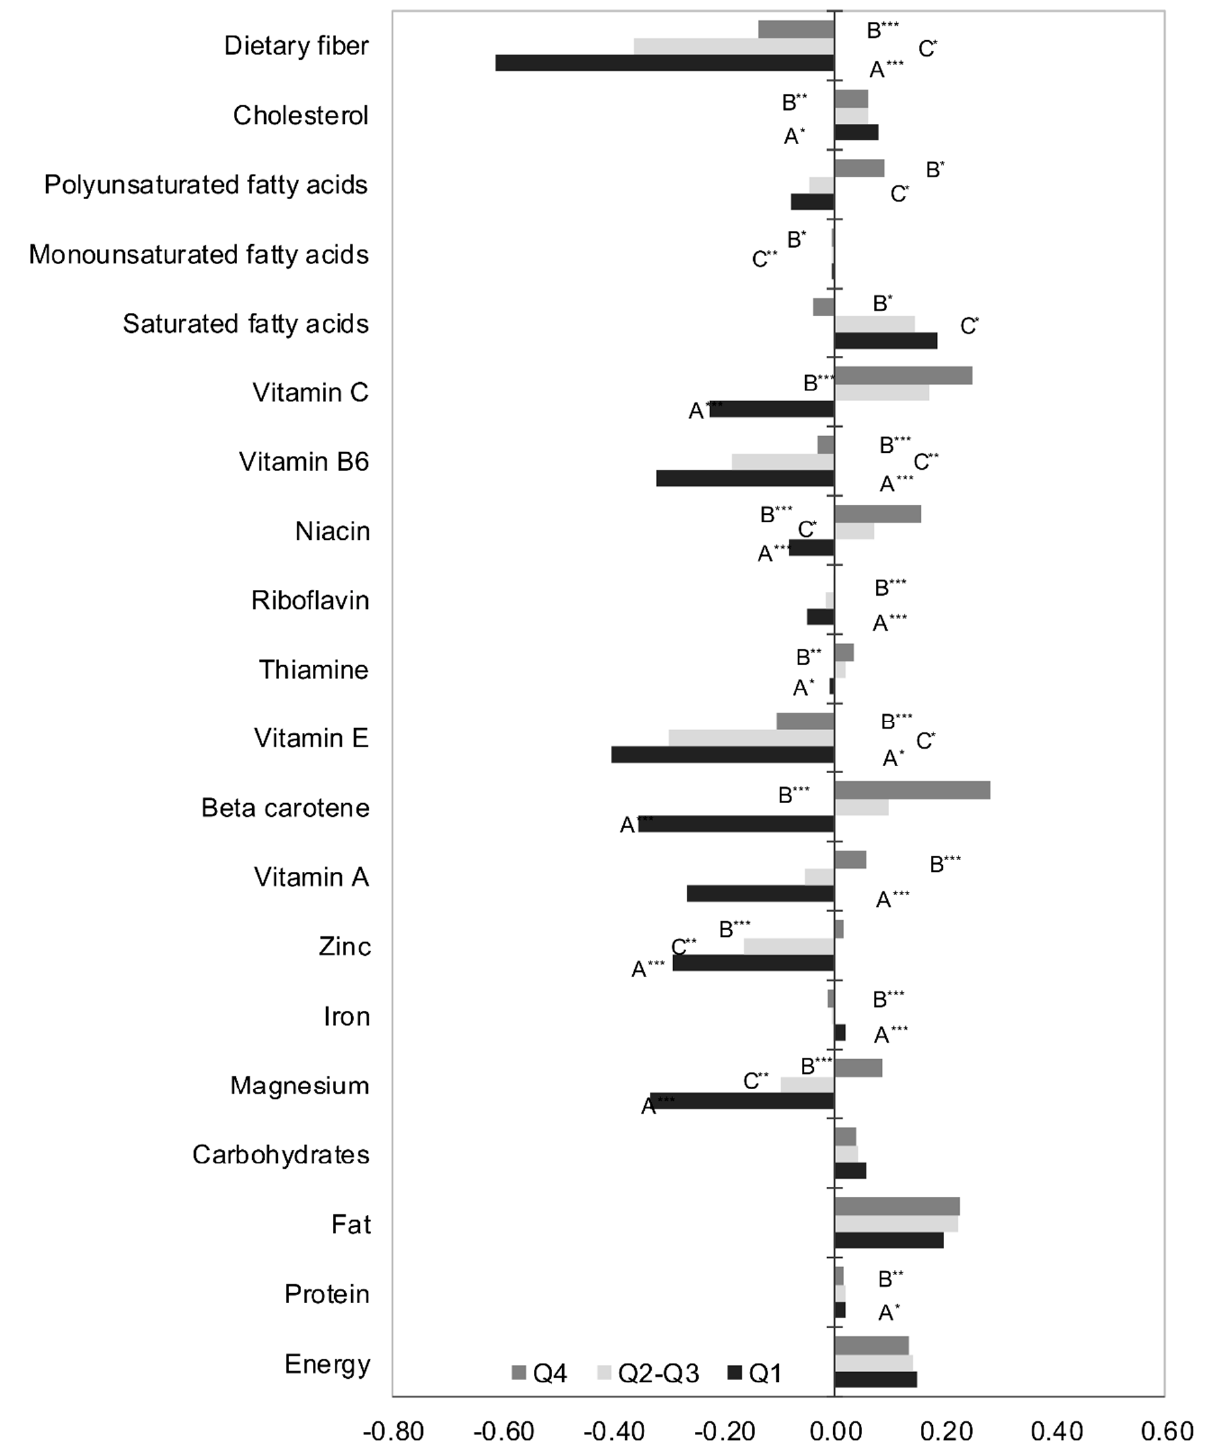
Figure 1. The overall inflammatory effect of energy, macro and micronutrients (mean value). A—significant differences between Q1 vs. Q2–Q3; B—significant differences between Q1 vs. Q4; C—significant differences between Q2–Q3 vs. Q4; * p < 0.05; ** p < 0.01; *** p < 0.001.